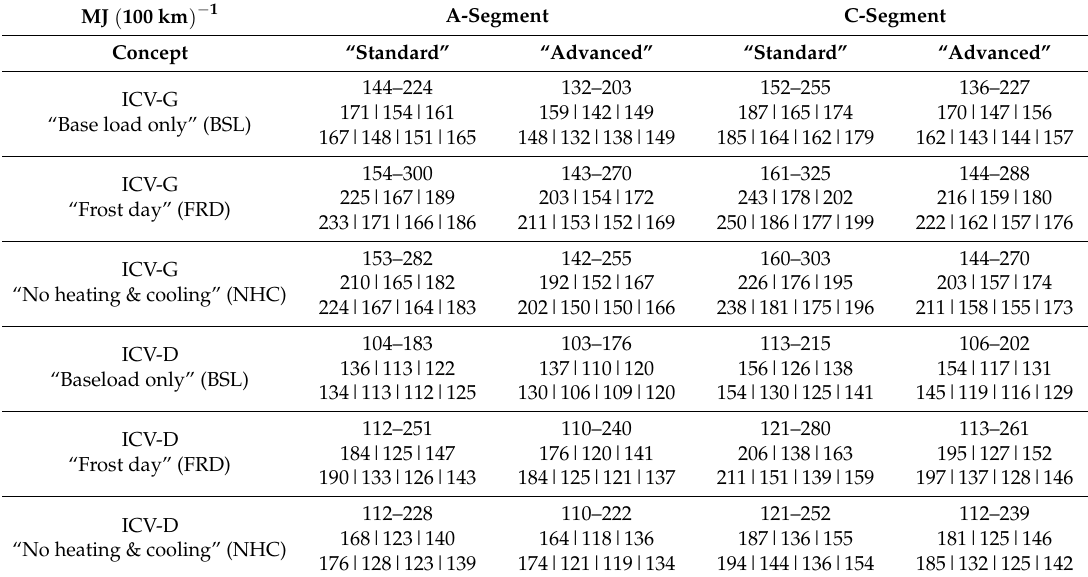
Table A4. Fuel economy figures of an ICV considering different load cases and drive cycles. First line: Range of results for all 25 drive cycles. Second line: Values for ECE|EUDC|MVEG; Third line: Values for WLTC-Low|WLTC-Middle|WLTC-High|WLTC-Very high. Values for cars with internal combustion engine vehicles based on spark ignition (ICV-G) and diesel engines (ICV-D).